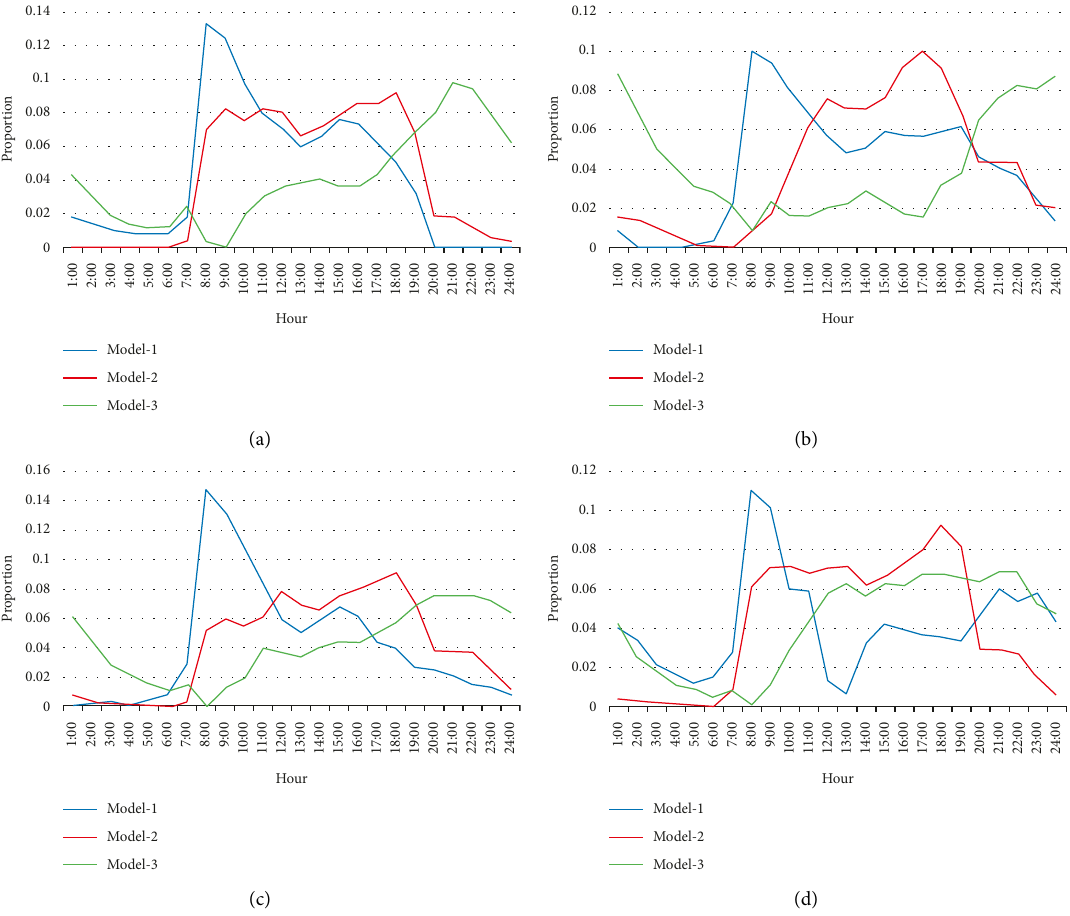
Figure 4: Three modes extracted at temporal dimension in four directions: (a) east to west, (b) west to east, (c)south to north, and (d) north to